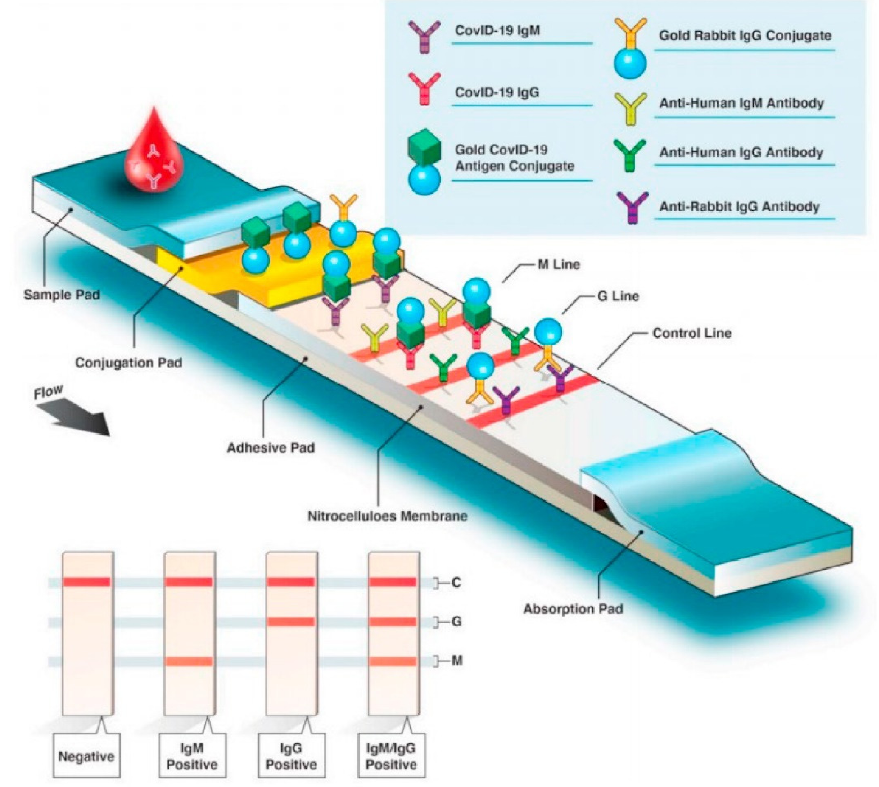
Figure 9. Overview of a rapid diagnostic serological test. Reprinted with permission from [45] under